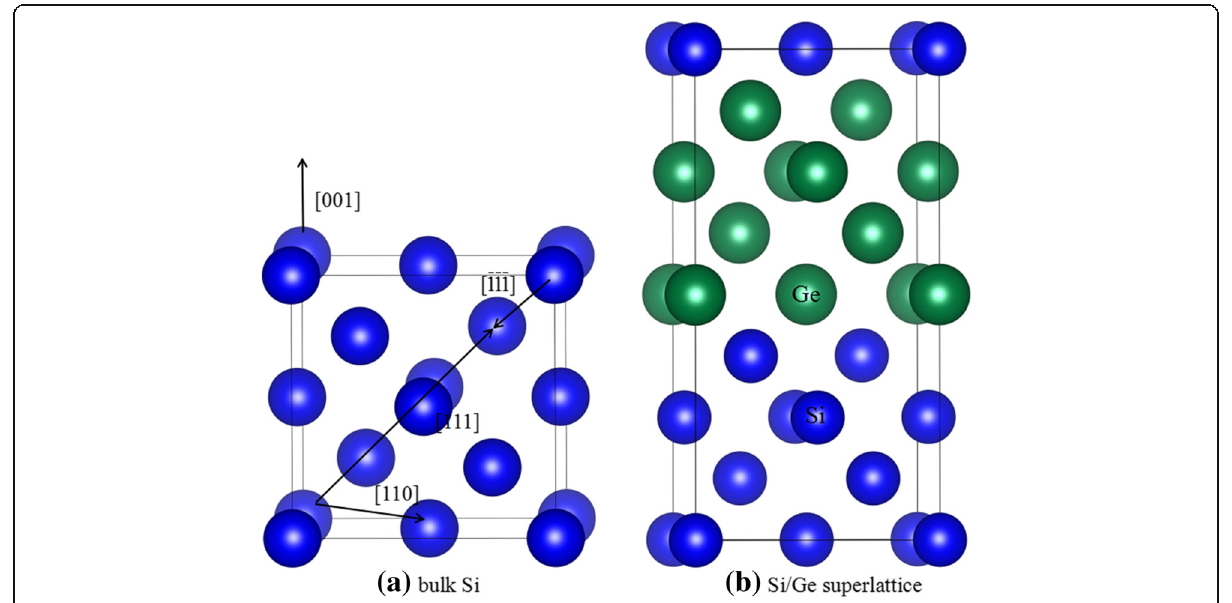
Fig. 1 Schematic view of geometrical structures of a bulk Si and b Si/Ge superlattice. The blue and green spheres represent the Si and Ge atoms, respectively